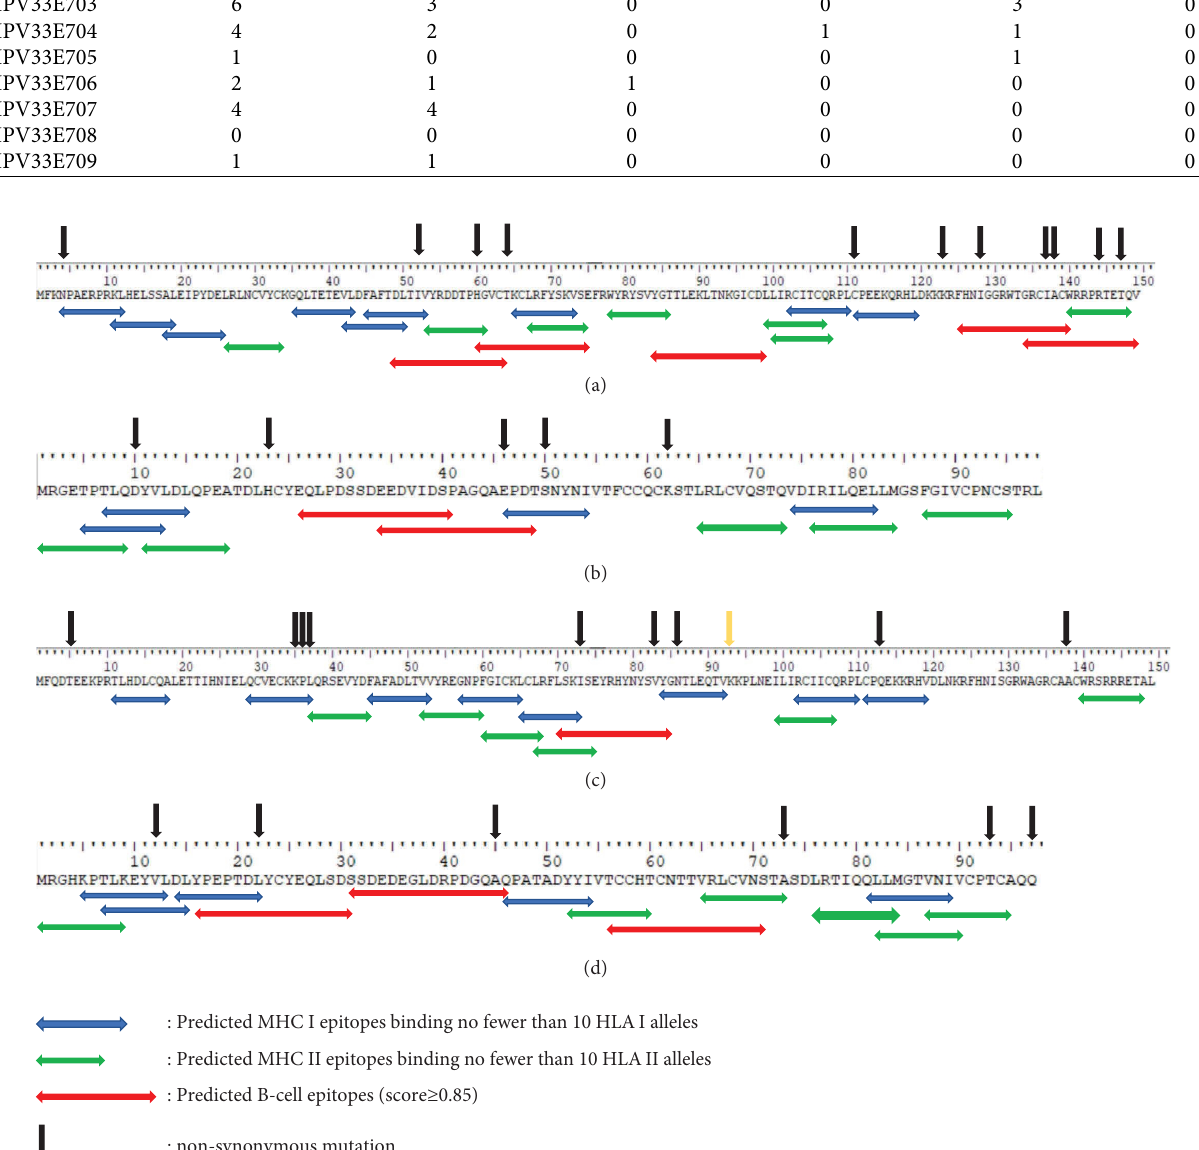
Figure 7: Predicted MHC and B-cell epitopes. (a) HPV31 E6 protein; (b) HPV31 E7 protein; (c) HPV33 E6 protein; (d) HPV33 E7